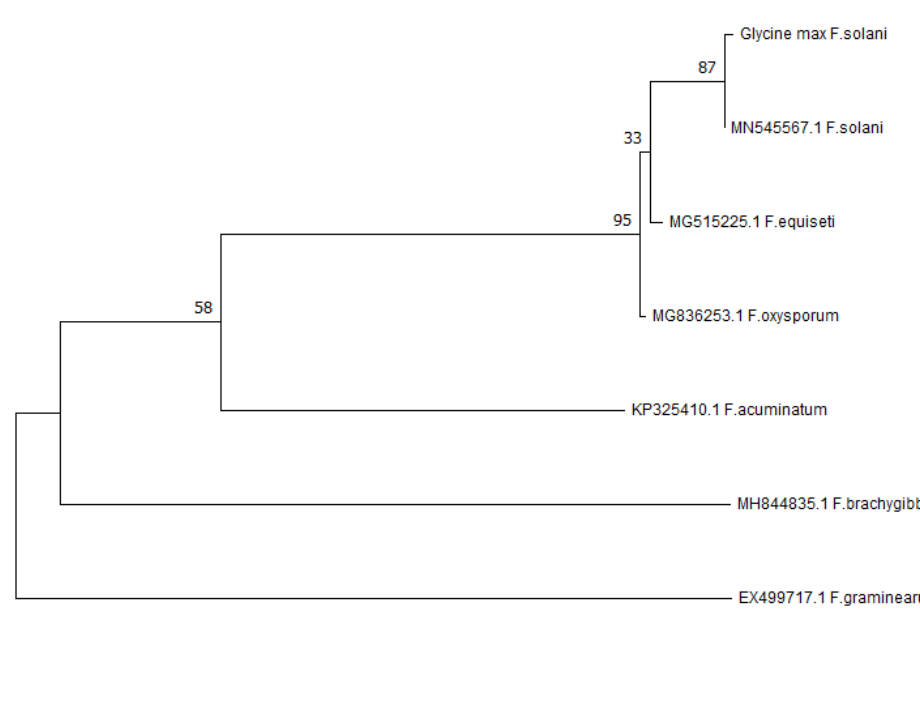
Figure 7. Root changes in G. max seedlings after inoculation with pathogenic fungi at ( a ) 0 h, ( b ) 24 h, ( c ) 3 d, and ( d ) 7 d.